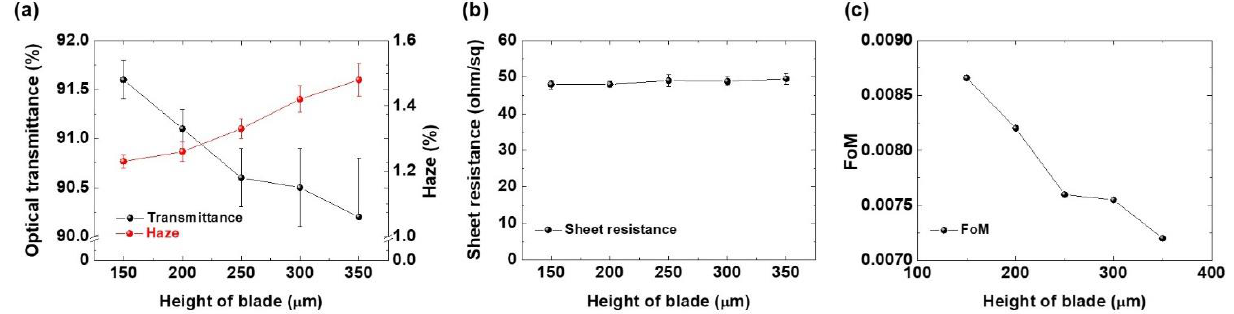
Figure 2. ( a ) Optical transmittance and haze, ( b ) sheet resistance, and ( c ) figure of merit (FoM) as a function of the blade